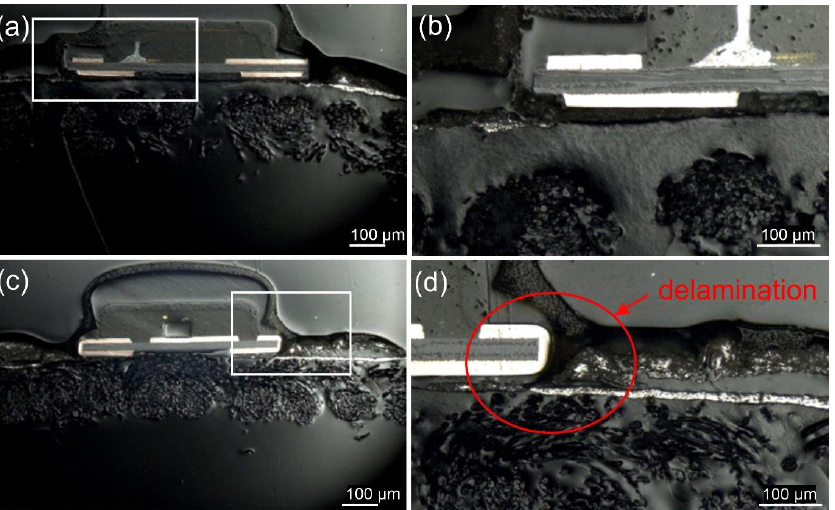
Figure 6. Cross-section SEM image of a properly conducting ( a , b ) and delaminated joint ( c , d ) after 10 washing machine cycles.